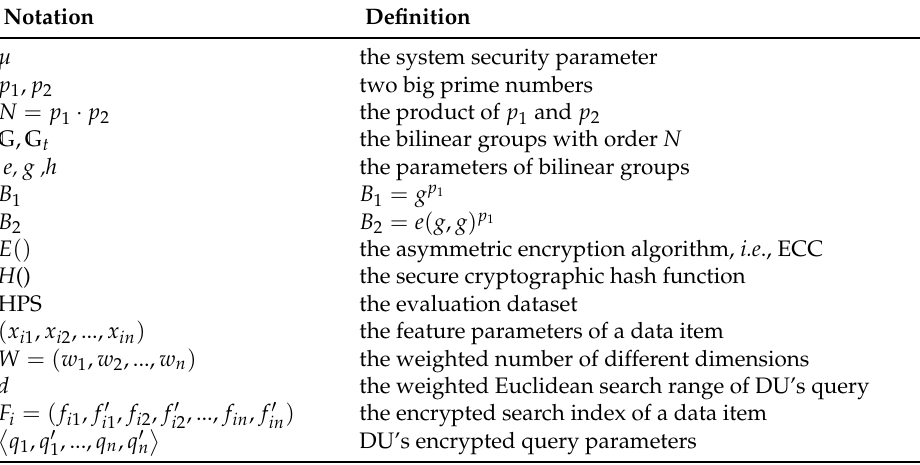
Table 1. Definition of notations in the proposed secure and privacy-preserving body sensor data collection and query (SPCQ)